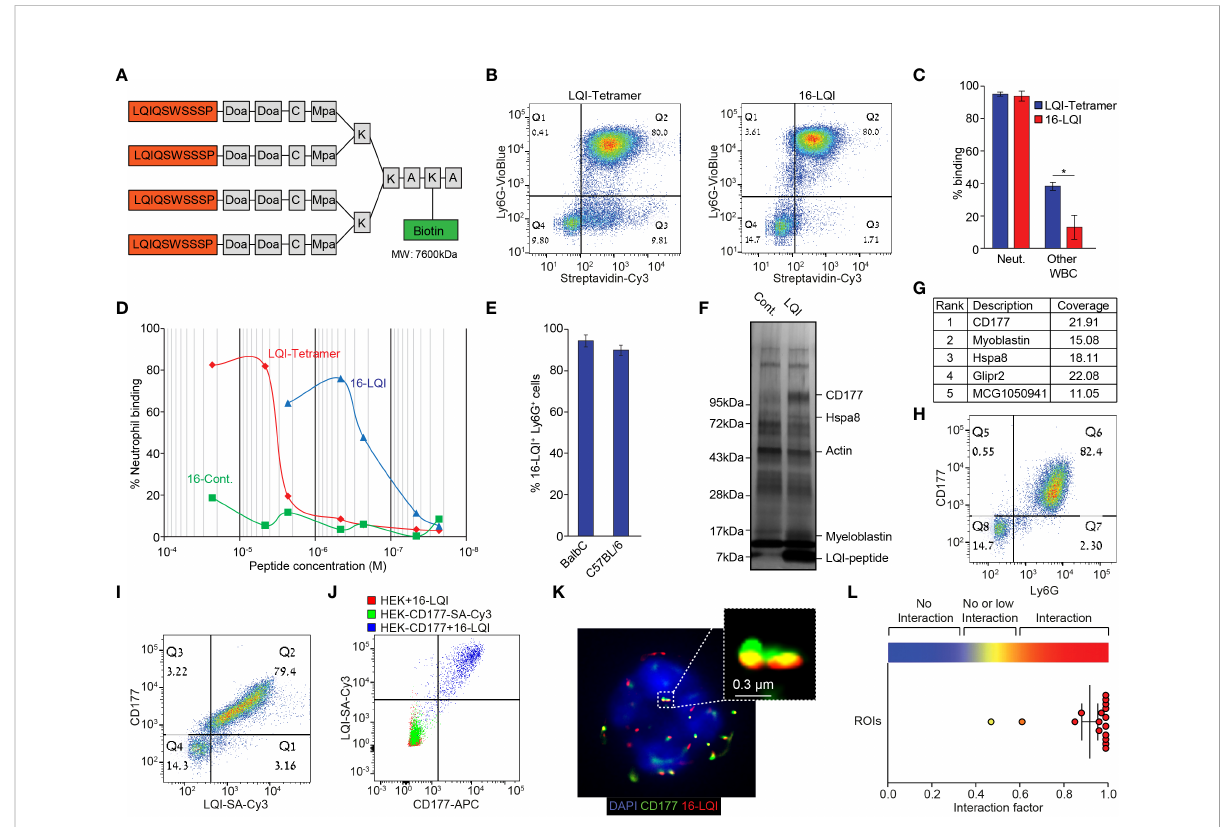
FIGURE 1 Murine Neutrophil-Speci fi c LQI-Peptide binding via CD177. (A) Schematic representation of the biotin-LQI-tetramer. (B) FACS analysis comparing the binding of LQI tetramer (left) and 16-LQI (right) to WBC following 20 min. incubation with 1 m M of each. (C) Quanti fi cation of LQI tetramer (blue) or 16-LQI (red) binding to neutrophils and other WBC. (D) Mouse neutrophils were incubated with the LQI-tetramer, the 16-LQI complex and the 16-Cont. (human neutrophil binding peptide - KFP) complex in increasing concentration. The samples were then analyzed by fl ow cytometry and the presented shows the fraction of Cy3 + neutrophils (Ly6G + ). The 16-LQi and the 16-Cont. were preincubated with SA- Cy3, the LQI-tetramer was fi rst incubated with the cells and then incubated with SA-Cy3. (E) Quanti fi cation of FACS analysis of the extent of binding of 16-LQI (1 m M) to circulating Ly6G + neutrophils from healthy Balb/C and C57BL/6 mice (n=3). (F) Silver staining of the gel plotting the proteins pulled down using naked (Cont.) and LQI-tetramer decorated (LQI-peptide) SA agarose beads. (G) Top ranking proteins enriched by LQI-tetramer-SA pull down. (H, I) Representative dot plots of isolated WBC stained with Ly6G and CD177 (H) and CD177 and 1 m M LQI-tetramer (I) . (J) FACS analysis of 16-LQI binding to control HEK293T cells (Red), SA-Cy3 binding to HEK293T cells overexpressing the murine CD177 protein (Green) and CD177-overexpressing HEK293T cells were incubated with 16-LQI (blue). (K) Representative STORM imaging of a single neutrophil with staining of CD177 (green) and 16-LQI (red), overlay with bright fi eld (left) or DAPI staining of nucleus (right). (L) Quanti fi cation of CD177 and 16-LQI interaction for image depicted in (K) using the ImageJ Interaction Factor plugin (35). Error bars represent ± SEM. *